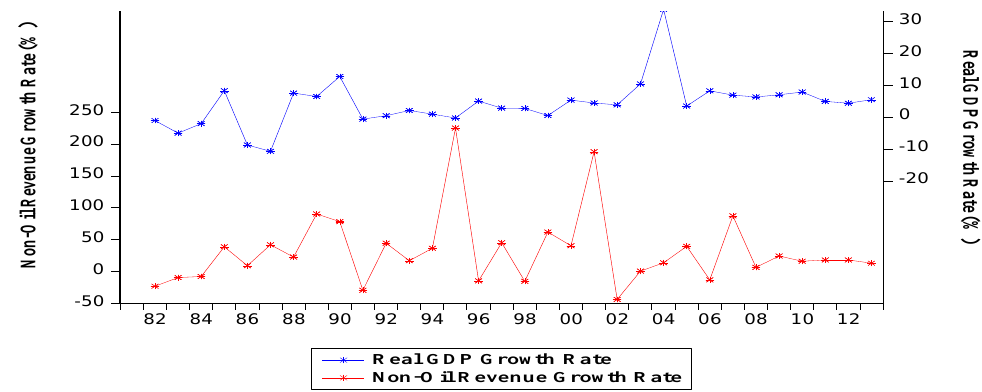
Figure 4 . Trend of real GDP and non-oil revenues growth rates